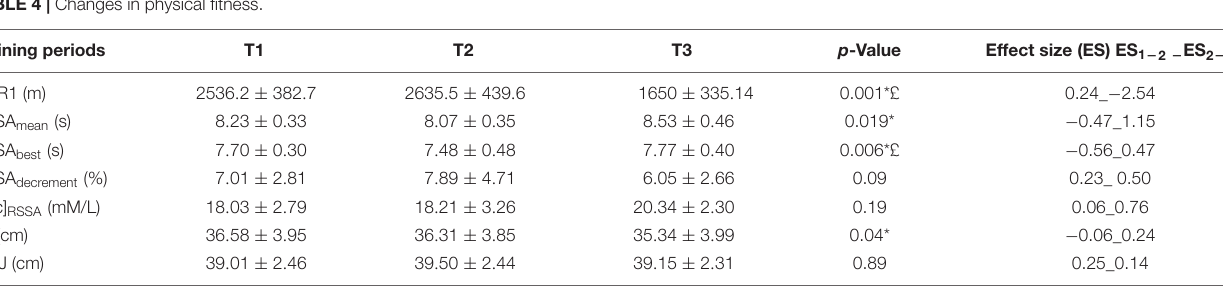
Data are represented as means ± SDs. YYIR1: Yo-Yo intermittent recovery test level 1. RSSA: Repeated Shuttle Sprint Ability. [Lac] RSSA : Lactate concentration was measured after the Repeated Shuttle Sprint Ability- test. SJ: Squat Jump, CMJ: Countermovement Jump. *Significant difference between T3-T2 and T3-T1 with p < 0.05.